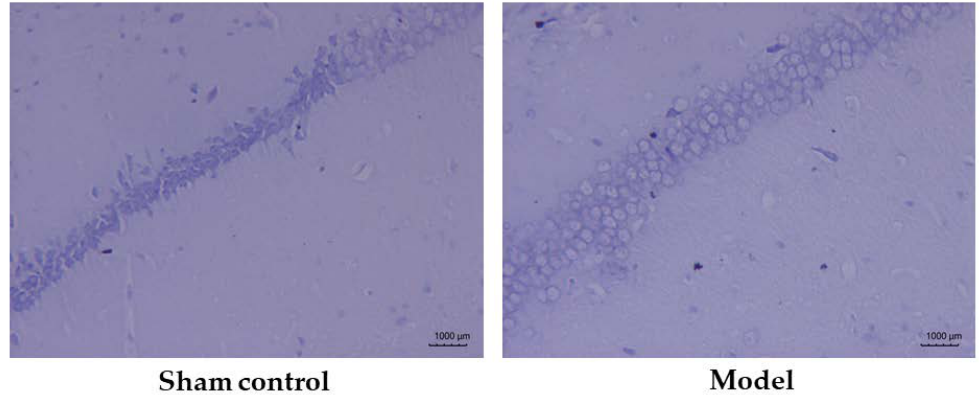
Figure 4. Pathological morphology of the hippocampal CA1 region in the sham control group ( n = 10) and model group ( n = 12).